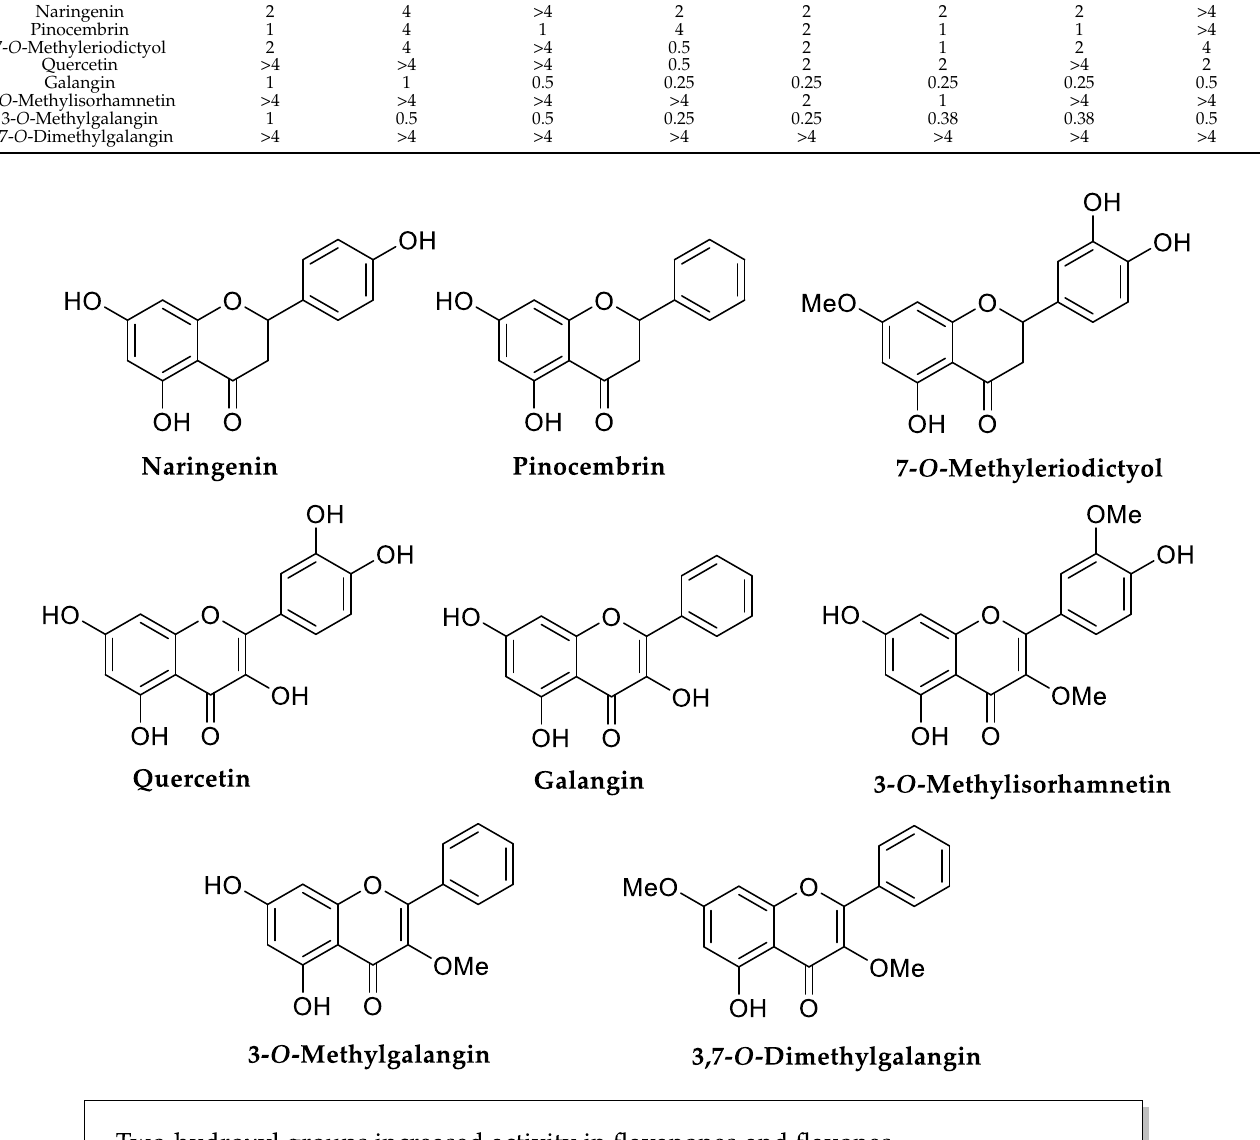
Table 5. Antibacterial activity of flavanones and flavones against Gram-positive and Gram-negative bacteria.